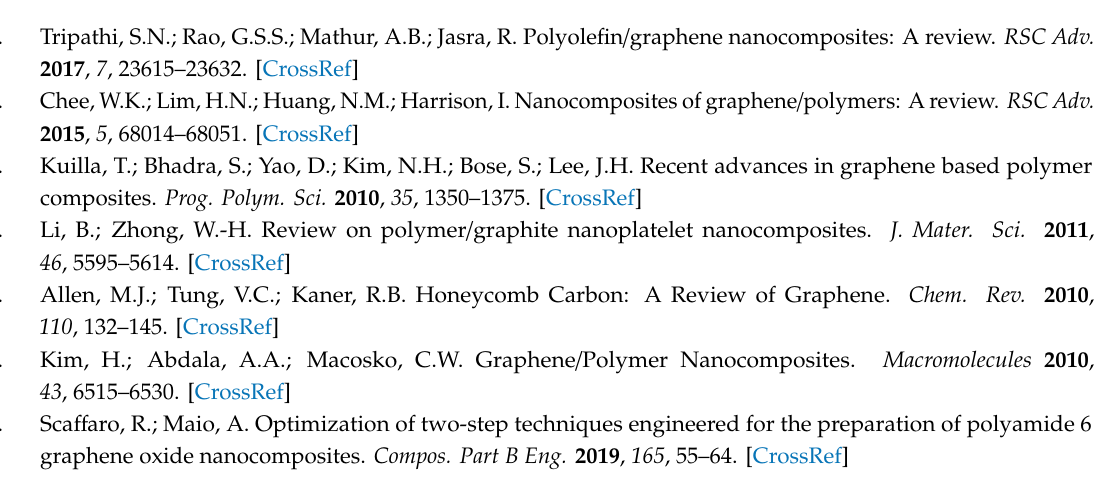
Figure S1: F1s XPS spectra of FGO_12, Figure S2: TGA data of PP, PP / GO, PP / RGO and PP / FGO_12